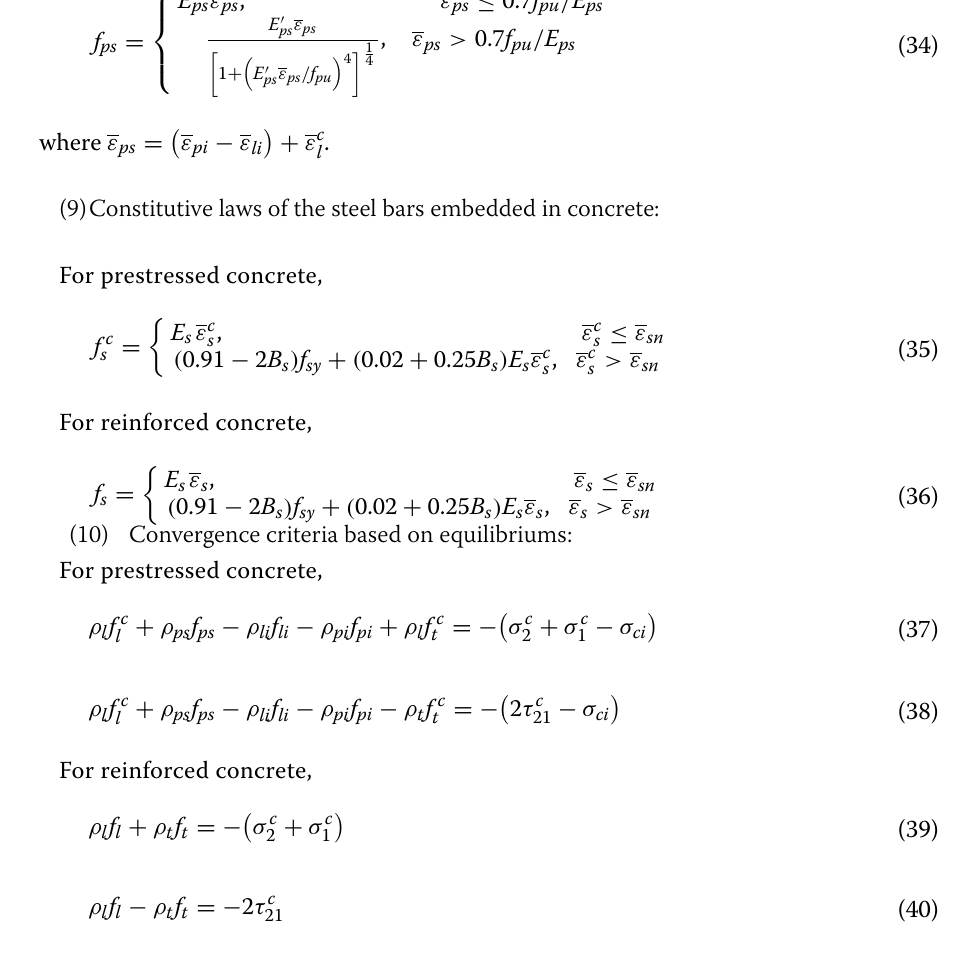
Abbreviations PC: Prestressed concrete; RC: Reinforced concrete; FE: Finite element; FEA: Finite element analysis; BGCSWs: Box-girders with corrugated steel webs; USMMT: Unified softened membrane model for torsion; CSWs: Corrugated steel webs; RA-STMT: Rotating-angle softened truss model for torsion; TS-STMT: Tension-stiffened softened truss model for torsion; MRA-STMT: Modified rotating angle softened truss model; USTMT: Unified softened truss model for torsion; URA-STMT: Unified rotating-angle softened truss model for torsion; FA-STMT: Fixed angle softened truss model for torsion; SMMT: Softened membrane model for torsion; ISMMT: Improved softened membrane model for torsion; DM: Displacement meters; IM: